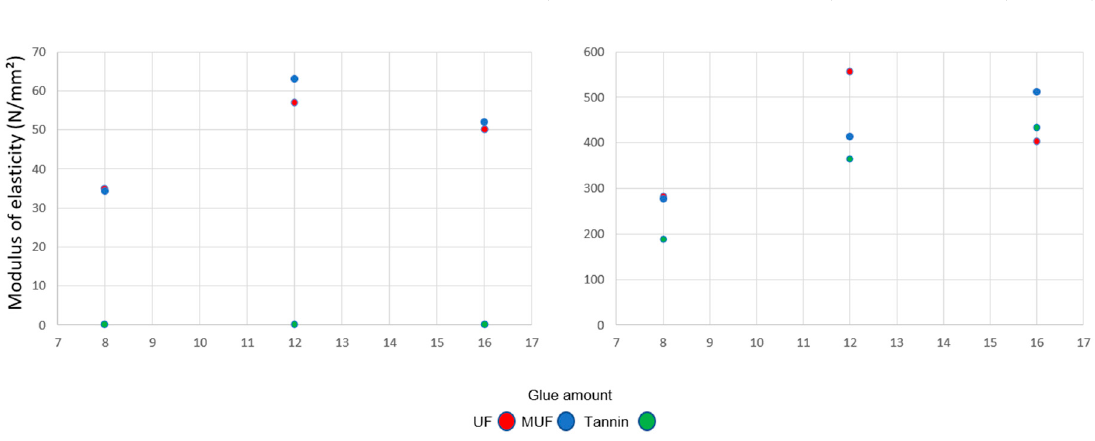
Figure 5. Internal bond at three levels of glue amount for 300 kg/m 3 ( left ) and 500 kg/m 3 ( right ). 3.5. Thickness Swelling and Water Absorption after 24 h The resin type significantly influences the TS and WA [27,40] reported about the increase in TS and WA when using tannin-based adhesives. For both density ranges, all the tannin-bonded samples recorded the highest values for thickness swelling (Figure 6) after 24 h of water immersion (18.5%, 11%, and 12%) for 8%, 12%, and 16% glue amounts (300 kg/m 3 ) and 26%, 16%, and 13% at a density of 500 kg/m 3 . The testing specimens bonded with UF had the lowest thickness swelling—under 10% for a density of 300 kg/m 3 and under 14.6% for 500 kg/m 3 .